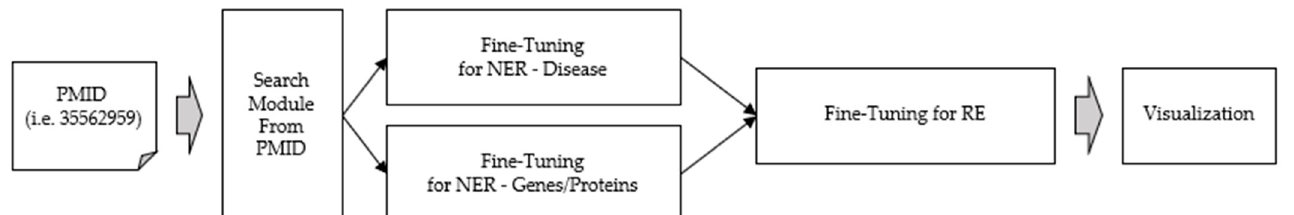
Figure 5. Our proposed web service’s schematic diagram.